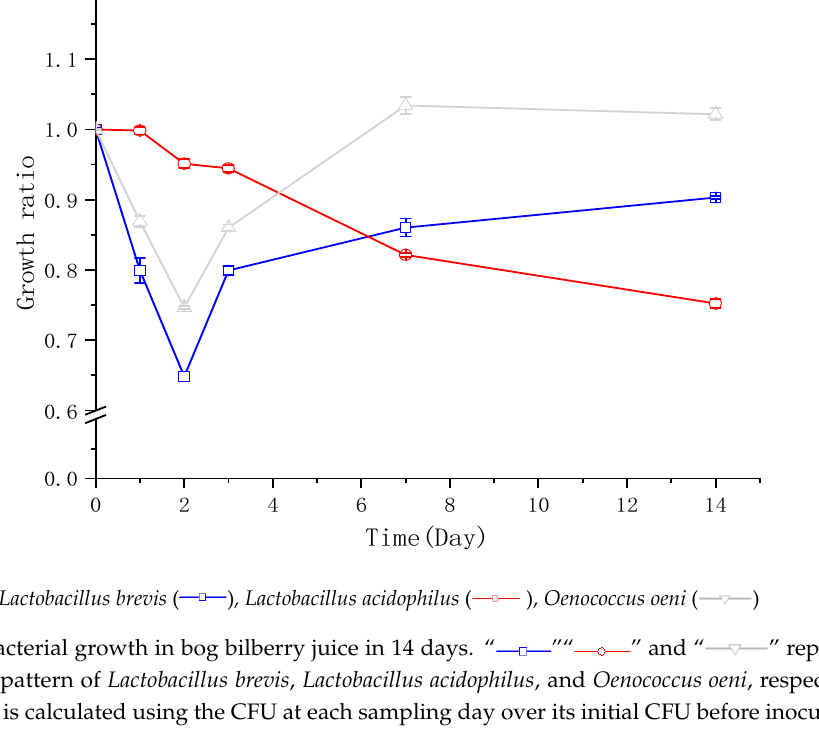
Figure 1. Bacterial growth in bog bilberry juice in 14 days. “ ”“ ” and “ ” represent the growth pattern of Lactobacillus brevis , Lactobacillus acidophilus , and Oenococcus oeni , respectively. The growth is calculated using the CFU at each sampling day over its initial CFU before inoculation. The data are the mean ± standard deviation of triplicate tests.